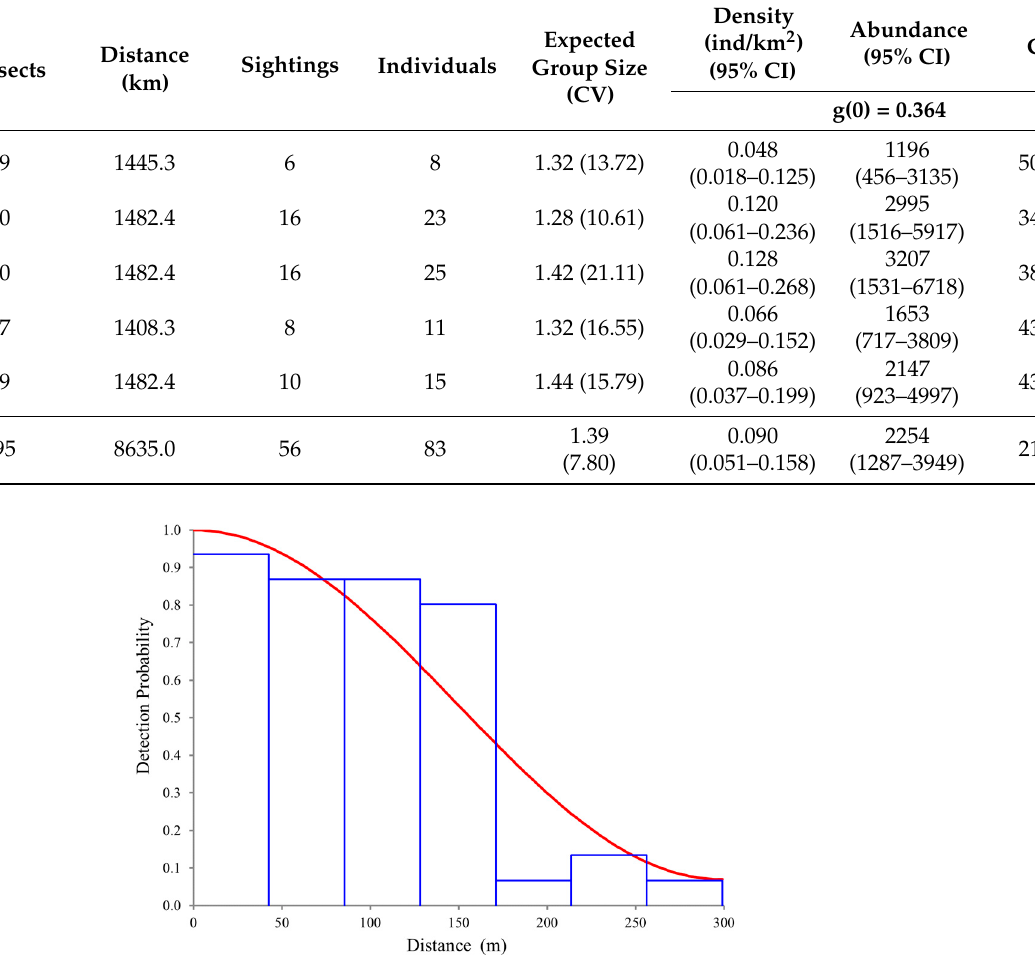
Figure 3. Histogram of harbour porpoise sightings ( n = 56) in the survey area at given distances from the transect line and corresponding global detection function using the uniform key with cosine adjustments (red line).